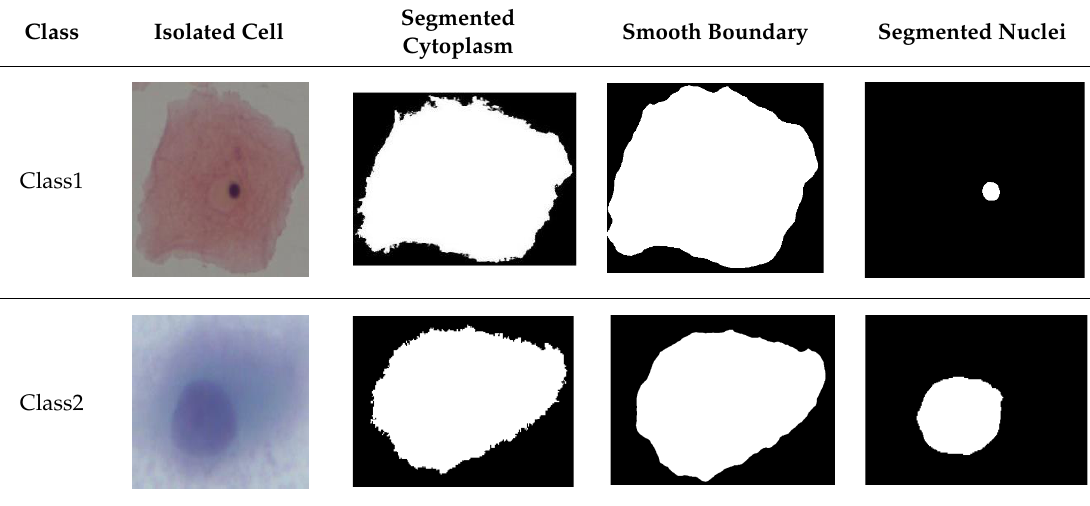
Table 7. Nuclei and cytoplasm Segmentation for isolated cells.